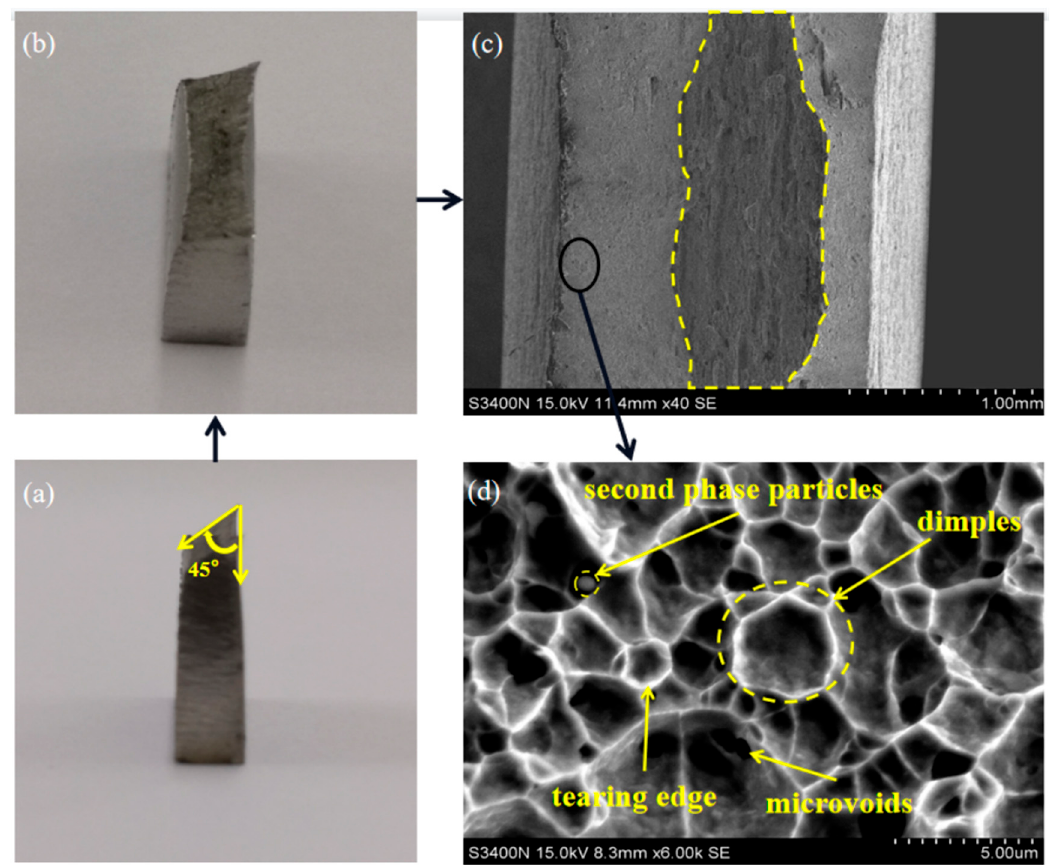
Figure 7. The fracture morphology of the FGH95 standard tensile sample. ( a ) Fracture cut along 45°; ( b ) fracture characteristics; ( c ) fracture magnified 40 times; ( d ) fracture magnified 6000 times.